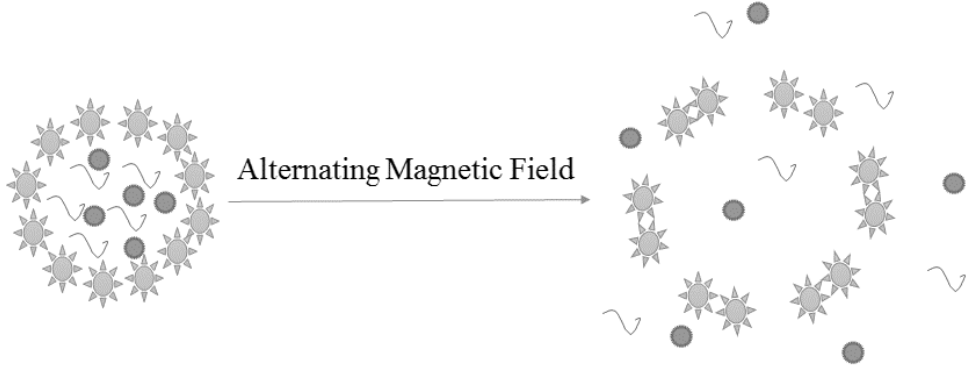
Figure 2. A concept figure showing drug release from magnetic nanoparticles under the effect of alternating magnetic field. Table 7. Polyphenol-loaded magnetic nanoparticles for the treatment of